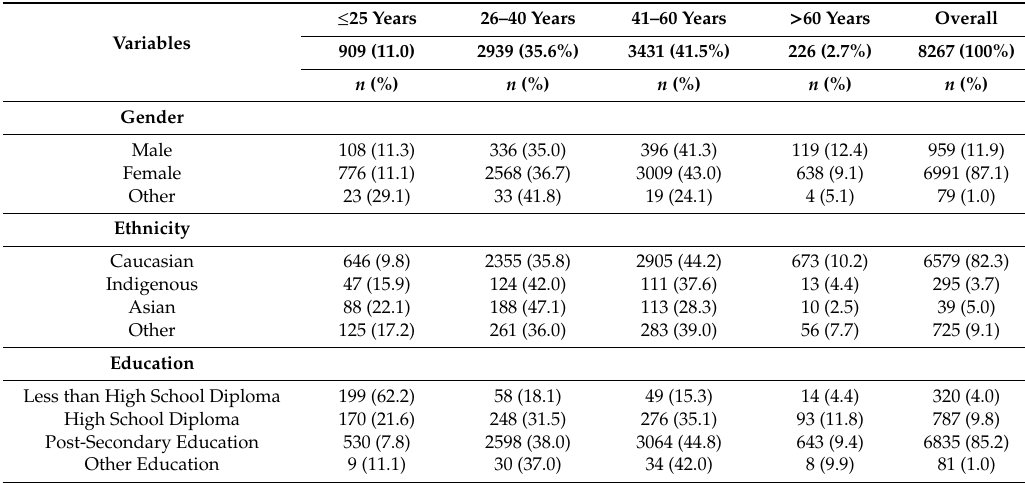
Table 1. Age distribution of demographic, clinical, and other characteristics of